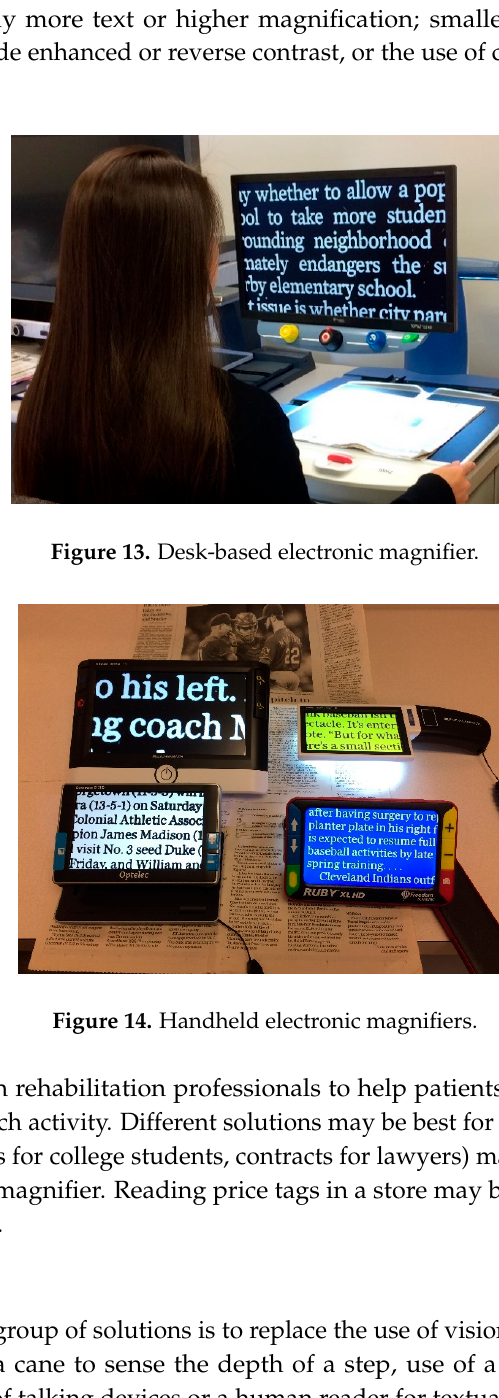
Figure 12. Stand magnifier with illumination.